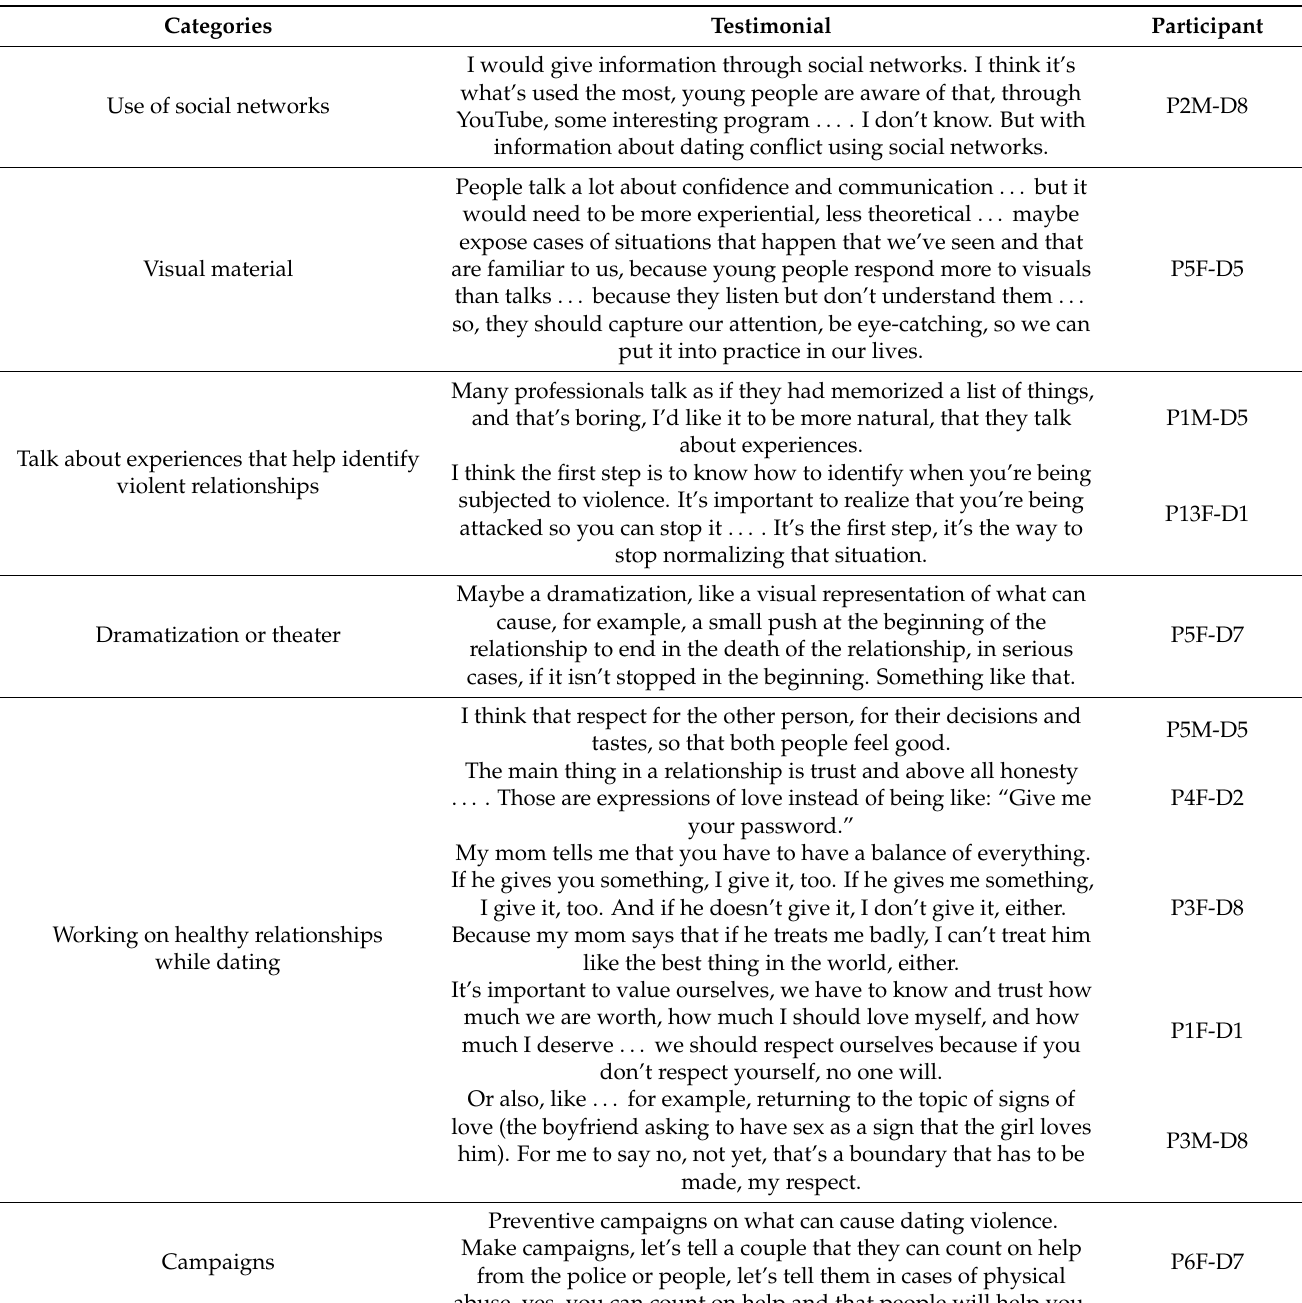
Table 6. Methodologies recommended for education in this